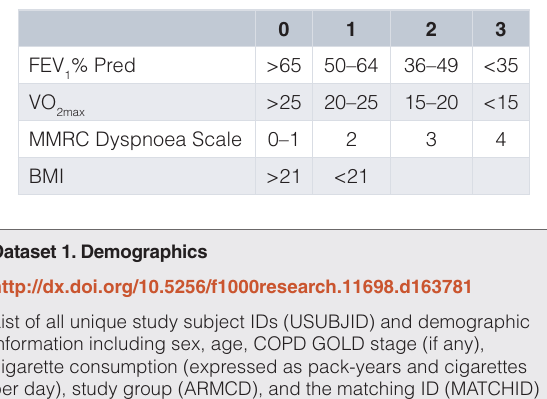
Table 1. Scoring matrix for the modified BODE index 24 .